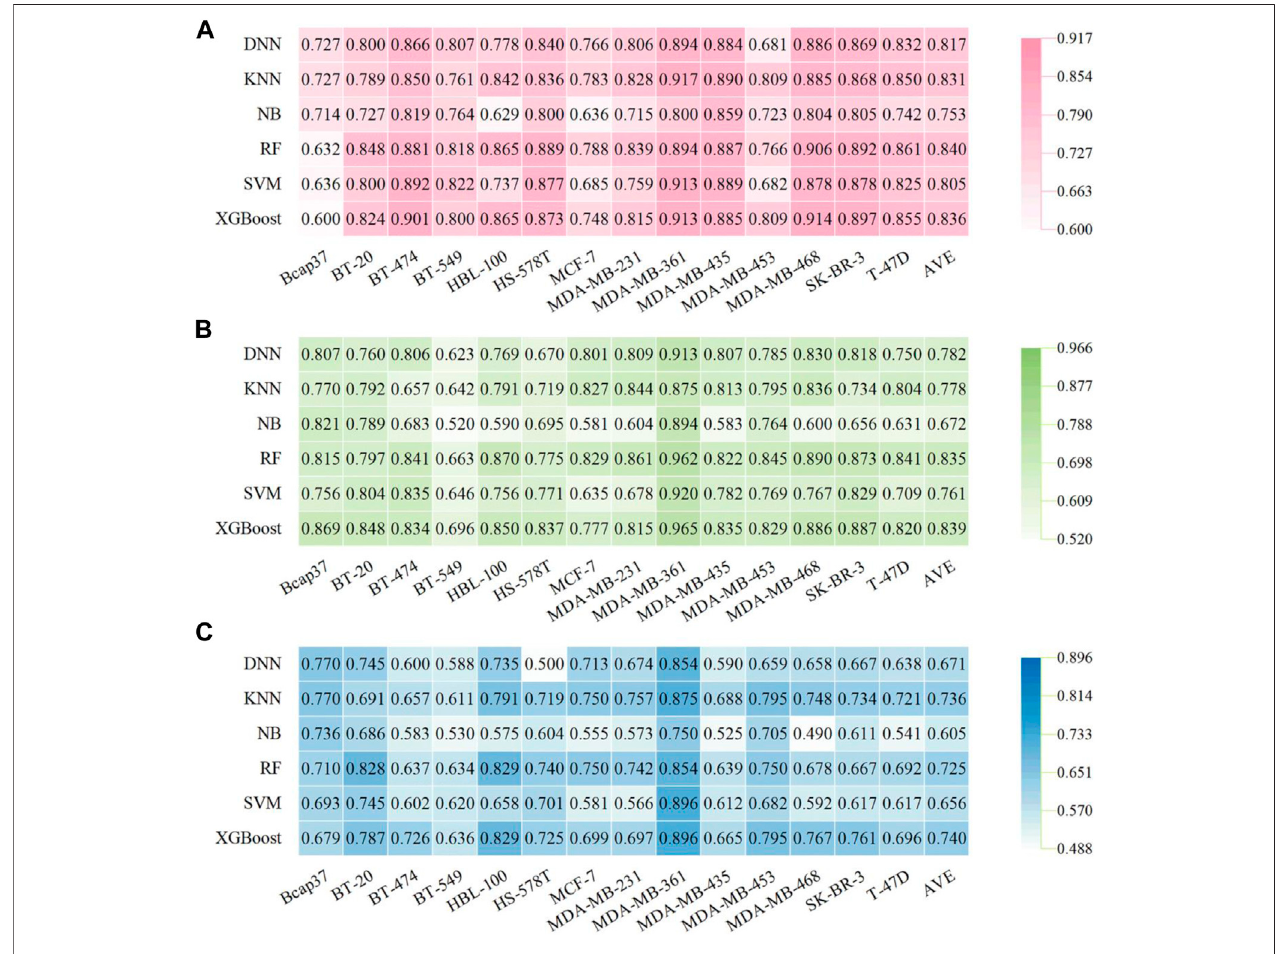
FIGURE 2 | Performance of descriptor-based BC prediction models. (A) F1 scores of descriptor-based models. (B) AUC results of descriptor-based models. (C) BC results of descriptor-based models.